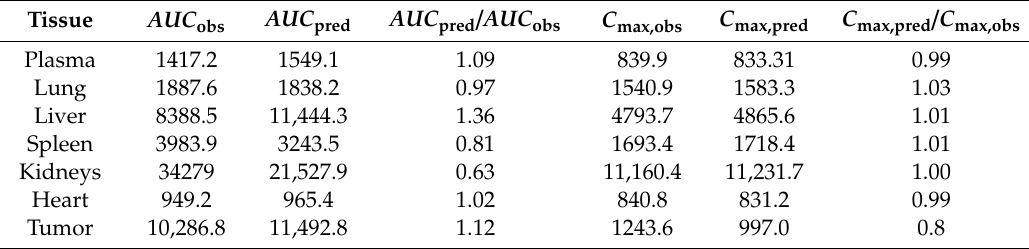
Table 3. AUC 0-t and C max values of MBQ-167 with the corresponding fold error after IP single dose administration of 10 mg / kg of MBQ-167 in